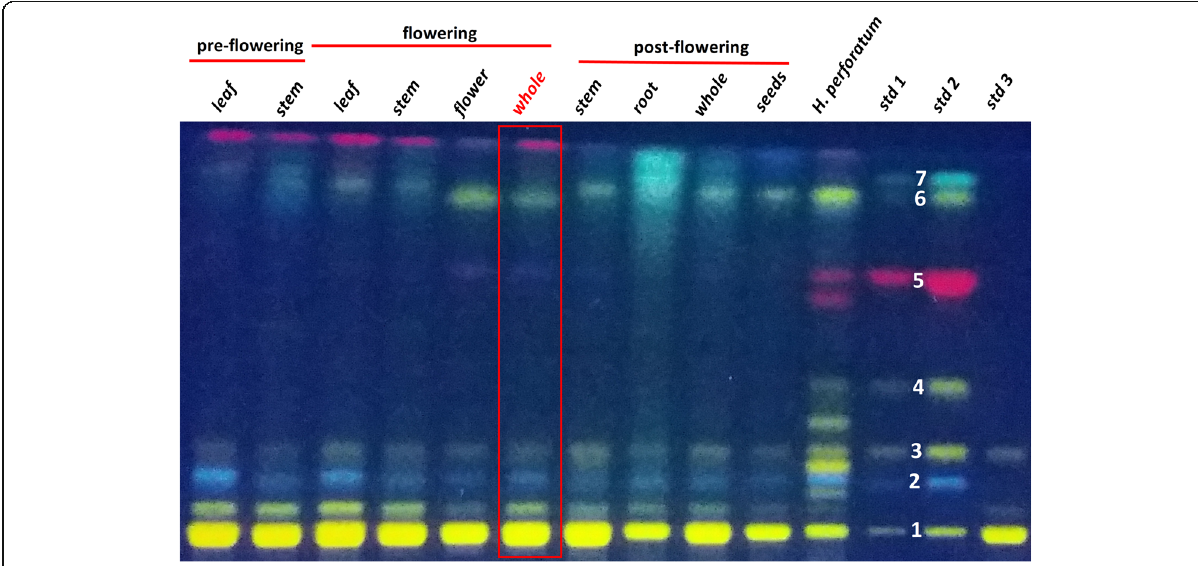
Fig. 1 HPTLC analysis results indicating the main secondary metabolites contained by Hypericum capitatum extracts (each lane contains 8 μ L of 10 mg/mL). Std1 – 2 μ L and std. 2 – 10 μ L of standards mixture containing rutin (1 – Rf=0.07), chlorogenic acid (2 – Rf=0.18), isoquercitrin (3 – Rf=0.26), hyperoside (4 – Rf=0.41), hypericin (5 – Rf=0.67), quercetin (6 – Rf=0.86) and kaempferol (7 – Rf=0.89), all at 100 μ g/mL. Std3 - standard of rutin solution – 2 μ L from